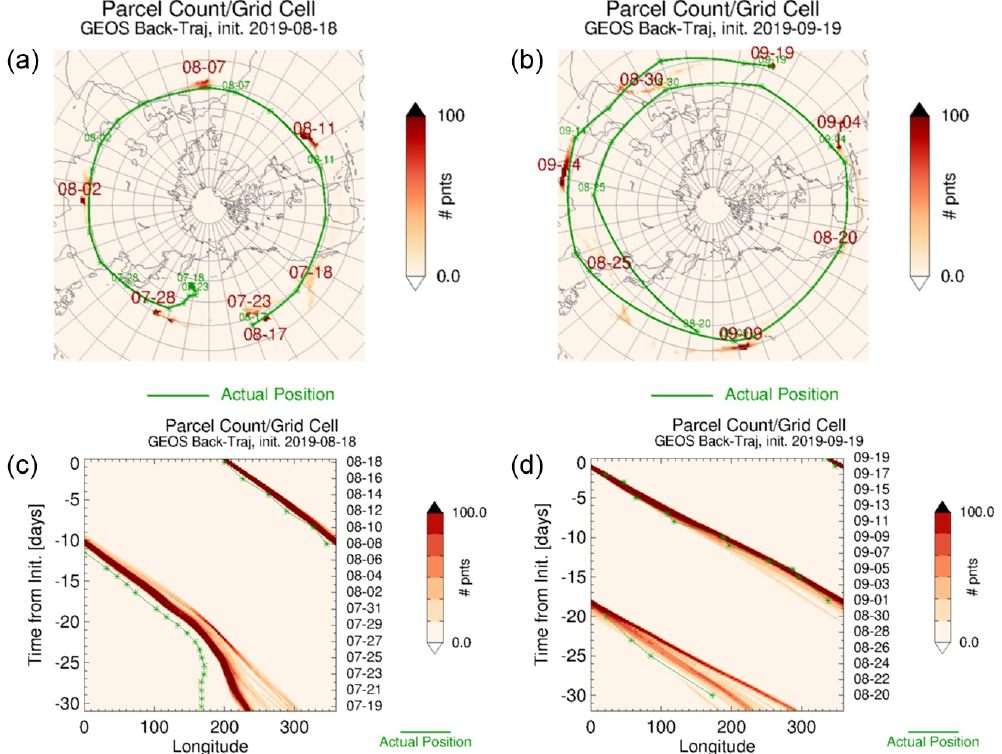
Figure 18. Backward trajectory modeling. Panel (a) shows several discrete time snapshots from the Goddard “ftraj” back-trajectory modeling for 3000 parcels within a 150km radius of the observed CCC position initialized on 18 August 2019. (b) The trajectory model run was initialized with the observed cloud position on 19 September 2019 and then run backwards to 18 August 2019. Panel (c) shows the same model results as for panel (a) but using a different visualization. Here the parcels are binned and counted in longitude and time, regardless of altitude or latitude. (d) Similar to panel (c) , except that the model run is initialized on 19 September 2019 and run backwards to 18 August